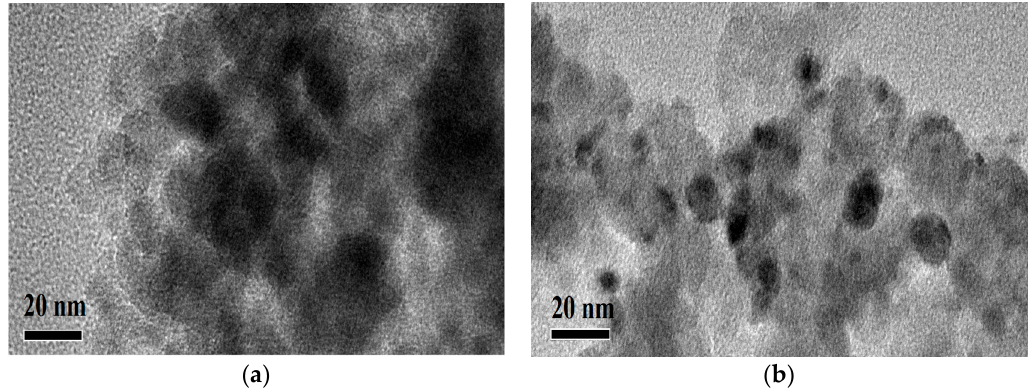
Figure 3. TEM images of ( a ) Ni CR /SiO 2 and ( b ) Ni DR /SiO 2 .